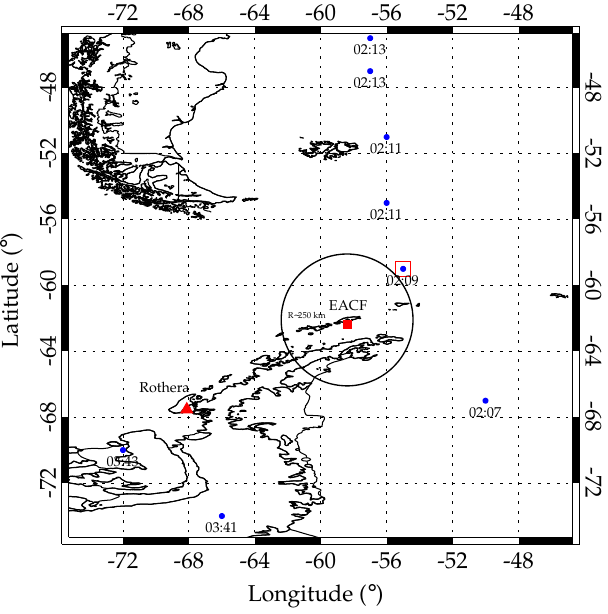
Fig. 3. Geographical map showing the location of the Comandante Ferraz Antarctic Station (EACF) denoted by the red filled box, and Rothera station is denoted by the red filled triangle. The sounding points of the Timed/Saber for 16 July are showed in blue dots and the hours are in Local Time. The nearest sounding of Ferraz is selected in a red box and it was used in the